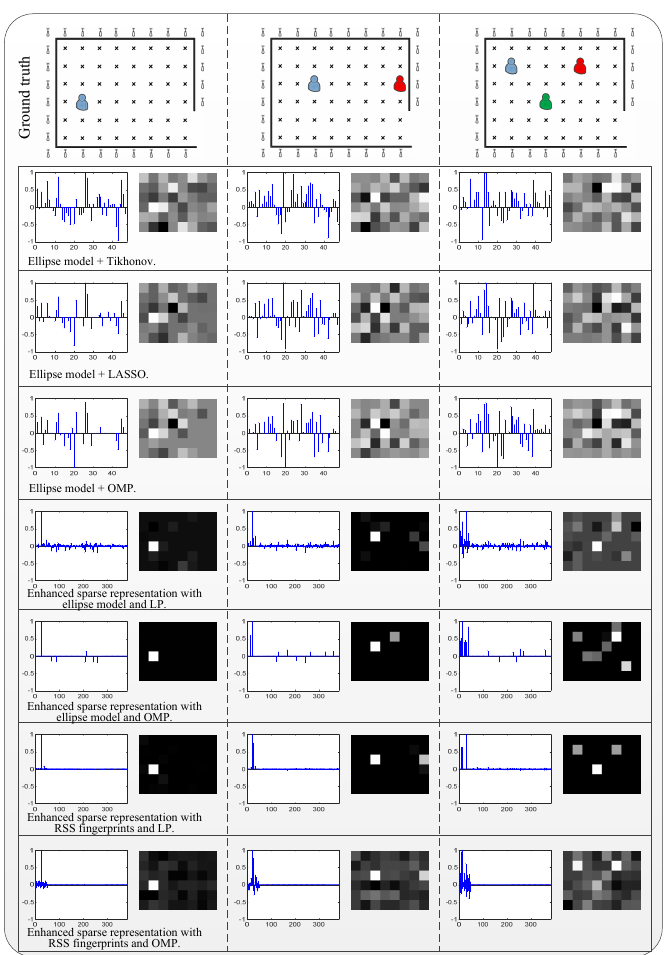
Figure 8. Imaging comparison of localizations with different methods in the indoor NLOS